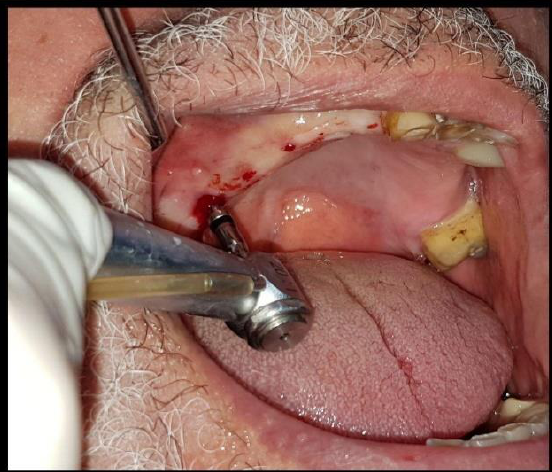
Figure 3: Drilling with pilot drill.